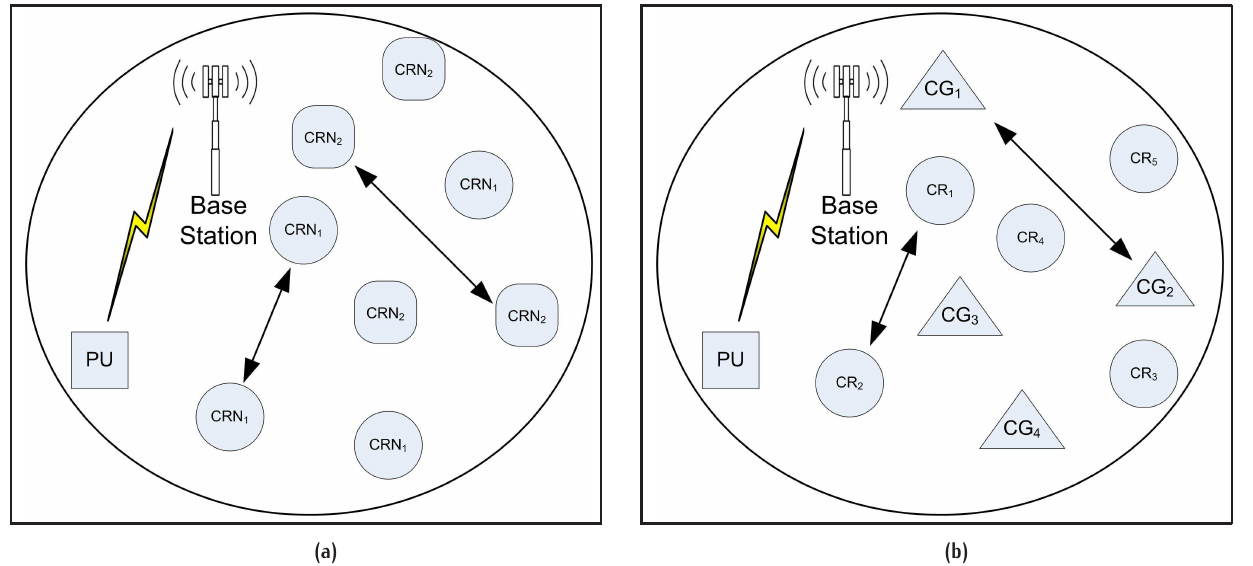
Figure 1. Physical network scenario, where two coexisting CR networks are within the range of a PU. (a) Equal Access (CRN1 and CRN2 ). (b) Prioritize Access (CGN and CRN).